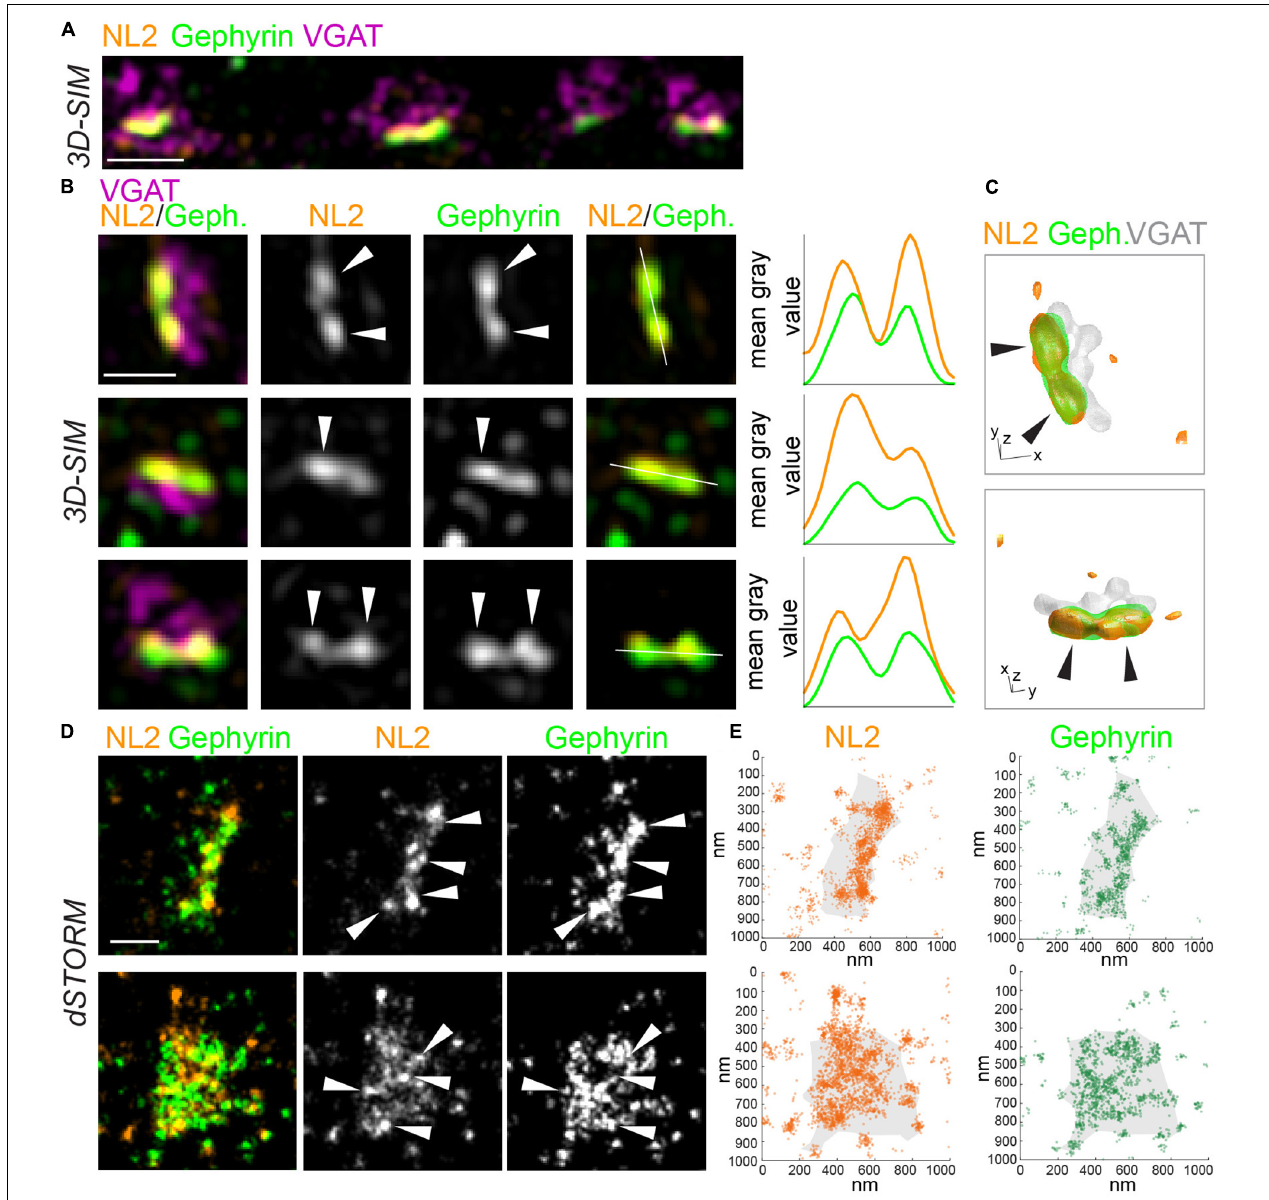
FIGURE 1 | SIM and d STORM reveal NL2 is organized into nanoscale structures at inhibitory synapses. (A) 3D-SIM maximum projection of hippocampal dendrite labeled with antibodies to NL2, gephyrin and VGAT. Scale bar = 1 µ m. (B) Magnifications of synapses from 3D-SIM images, with line-scans showing nanoscale subsynaptic domains (SSDs) of NL2 and gephyrin. White lines show path of line scans on the right. Arrows indicate NL2 and gephyrin SSDs. Scale bar = 500 nm. (C) 3D reconstruction of inhibitory synapse in panel (B) , upper panel, labeled for NL2, gephyrin and VGAT. XY scale bar = 320 nm, Z scale bar = 600 nm. Also